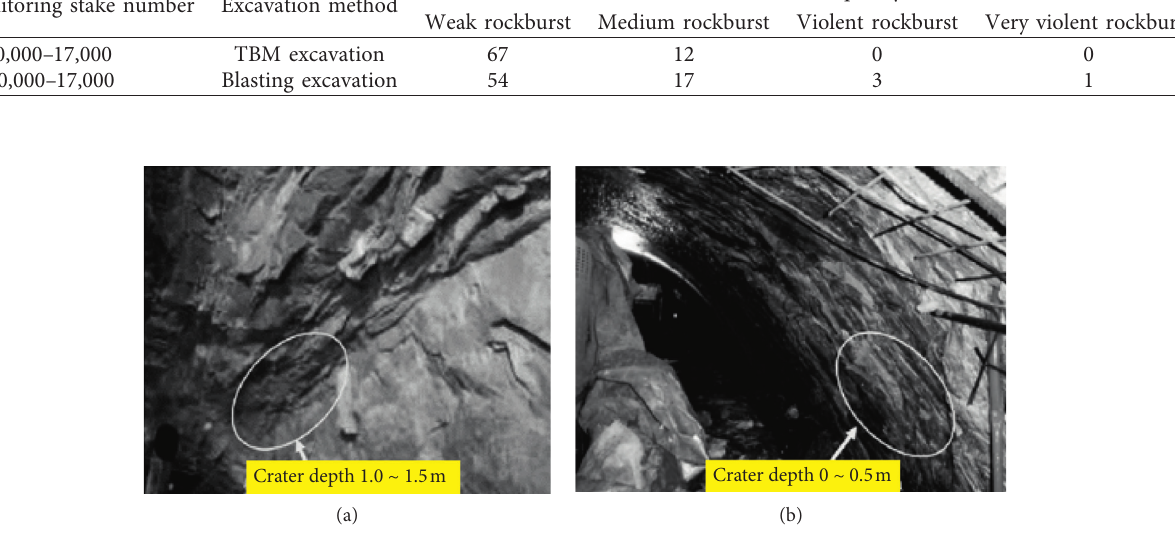
Figure 8: Surface of diversion tunnel after excavation [62]. (a) Blasting excavation. (b) TBM